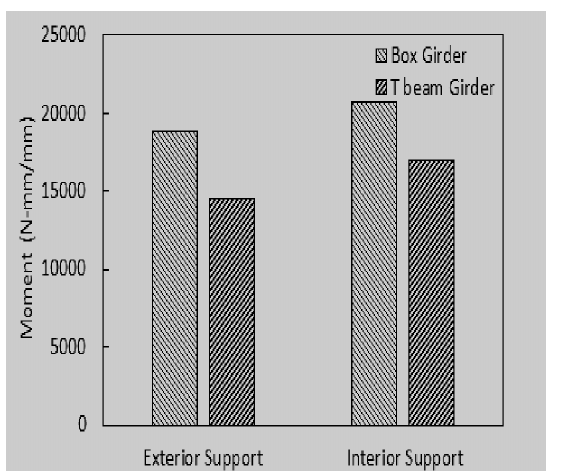
FIG. 8: COMPARISON OF MAXIMUM MOMENT FOR SLAB DESIGN FOR BOX AND T BEAM GIRDER